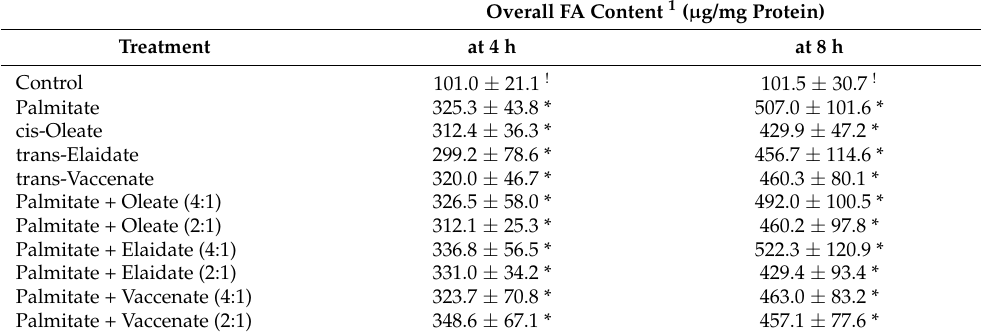
Table 2. Overall cell-associated fatty acids in lipotoxicity. Cells were treated with BSA-conjugated palmitate, oleate, elaidate or vaccenate (800 µ M) or with palmitate (800 µ M) and oleate, elaidate or vaccenate at a 4:1 or 2:1 molar ratio (200 or 400 µ M) at 70–80% confluence for 4 or 8 h. The overall amount of 10 relevant fatty acids was measured by GC-FID after saponification and methylation. Data were normalized to the total protein content of the samples and are shown as mean values ± S.D.; n ≥ 4; statistically significant differences: * p < 0.05 vs. BSA treated control; ! p < 0.05 vs. palmitate treated